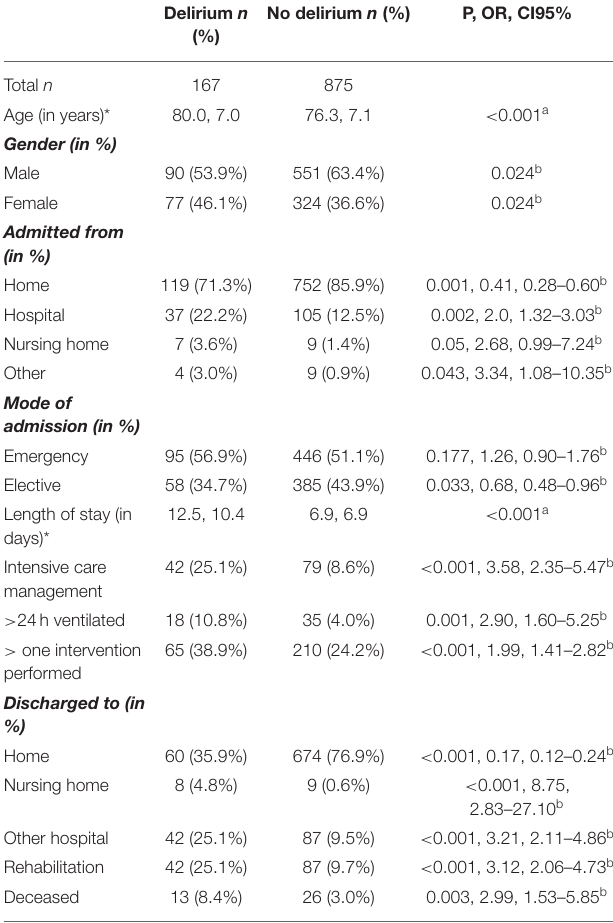
TABLE 2 | Sociodemographic and medical characteristics of cardiac patients with and without